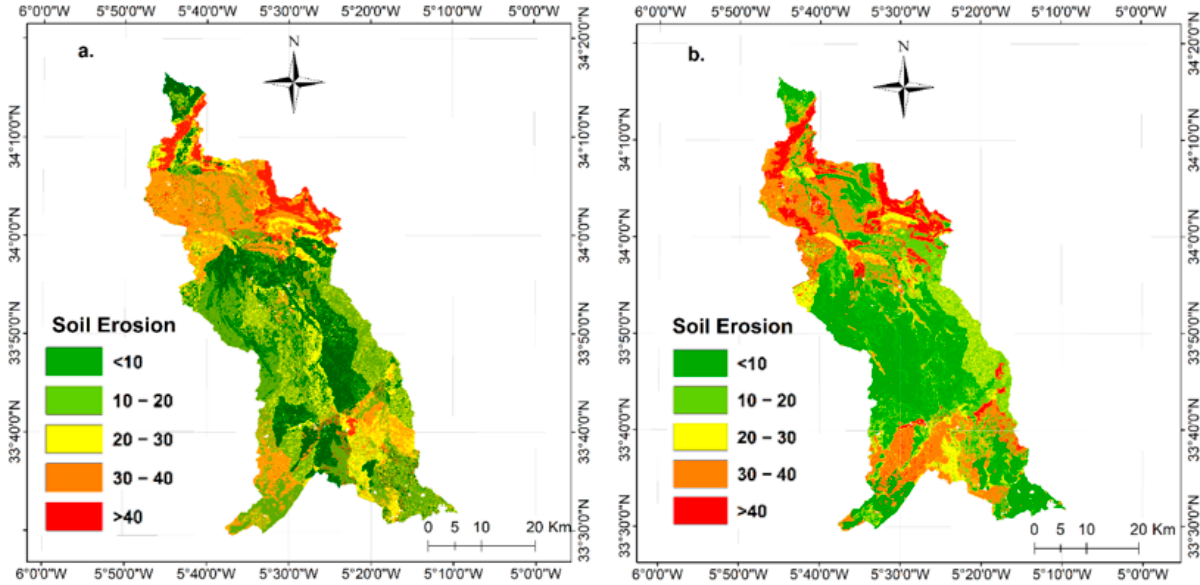
Figure 9. Soil erosion rate for using SWAT model ( a ) for the period 2000–2013, ( b ) for the period 2014–2027. Table 7. Soil erosion classes with area occupied using SWAT